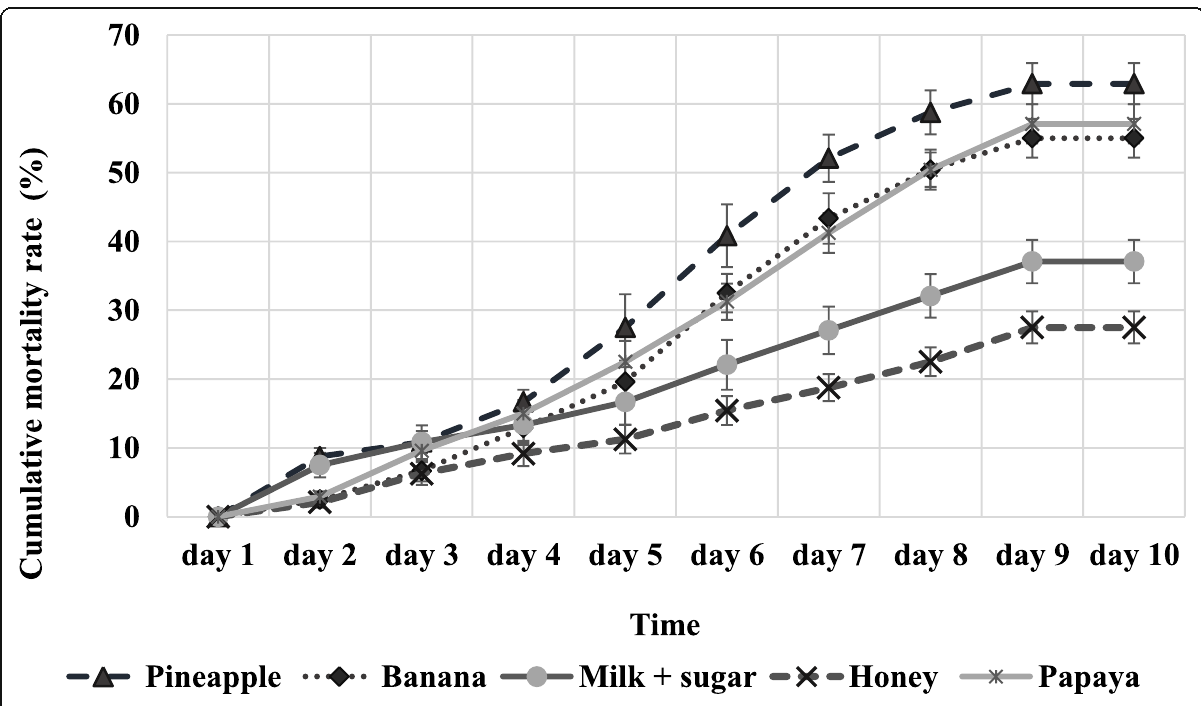
Fig. 1 Cumulative mortality rate of M. domestica adults. Error bars represent standard